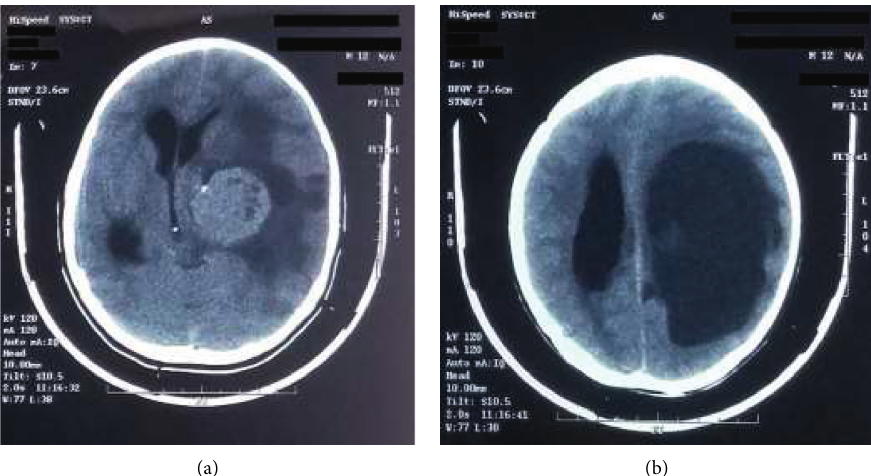
Figure 1: Preoperative simple CTof the brain. (a) 10 × 7cm mass in the posterior horn of the ventricle. (b) Lesion at the left parietal region accompanied by secondary ventricular dilation.